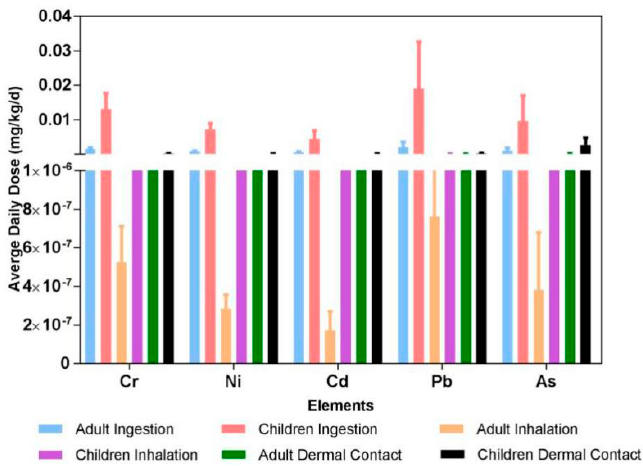
Figure 4. Average daily exposure dose for carcinogenic elements.